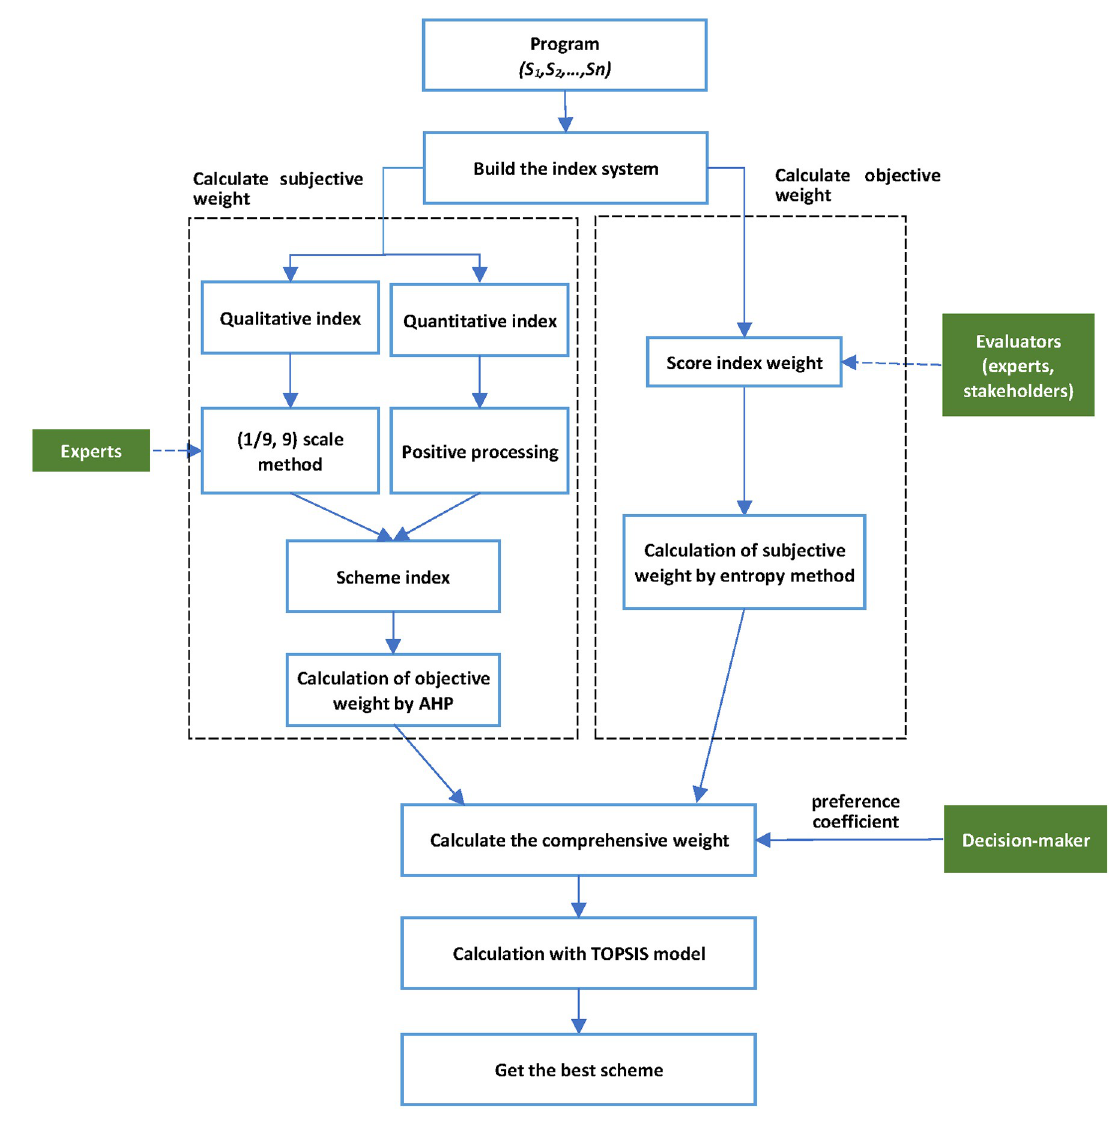
Fig 1. The highway route scheme optimization algorithm.